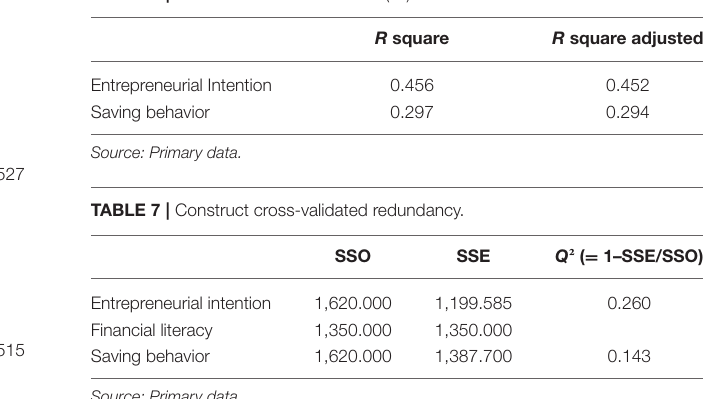
TABLE 6 | Coefficient of determination ( R ² ).